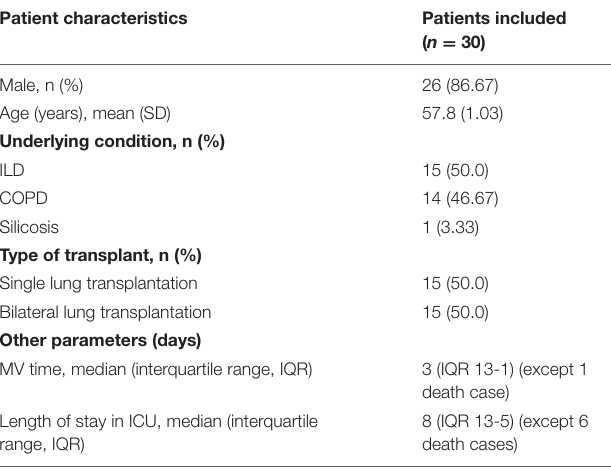
TABLE 1 | Demographic and clinical characteristics of the 30 patients with lung transplantation. Patient